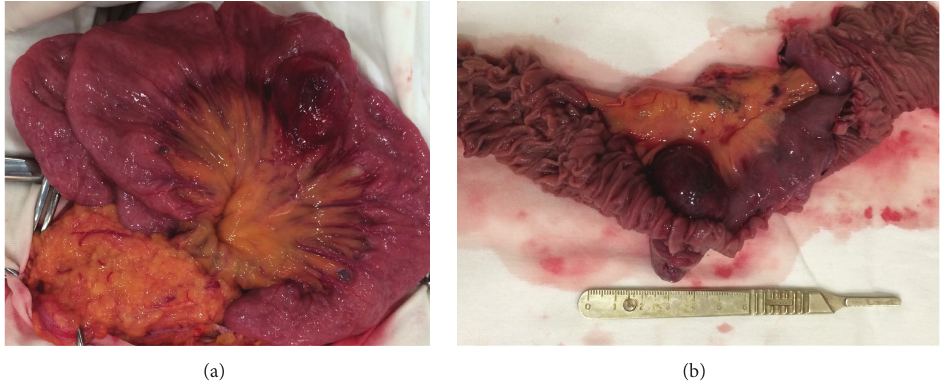
Figure 2: (a) Intraoperative and (b) postresection macroscopic appearance of small bowel